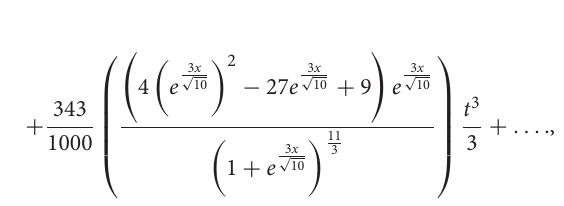
FIGURE 5 | Comparison of approx. sol. for different values of α and exact sol. at α 1, for Ex. =